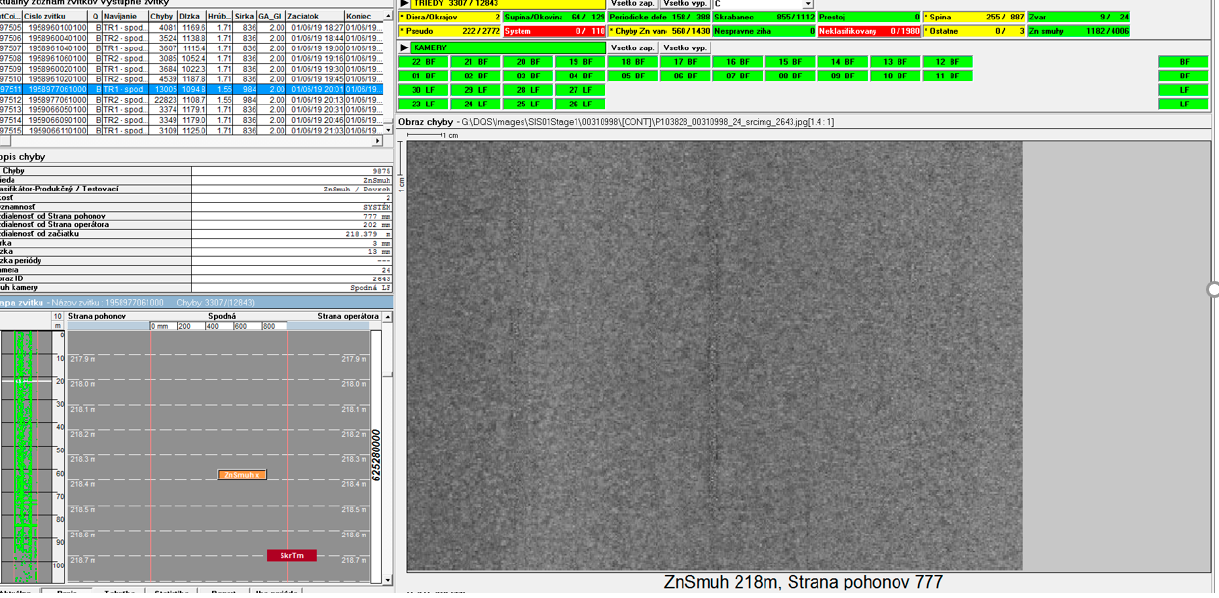
Figure 11. Scratch 5897706—identified after zinc-coated sheet metal.